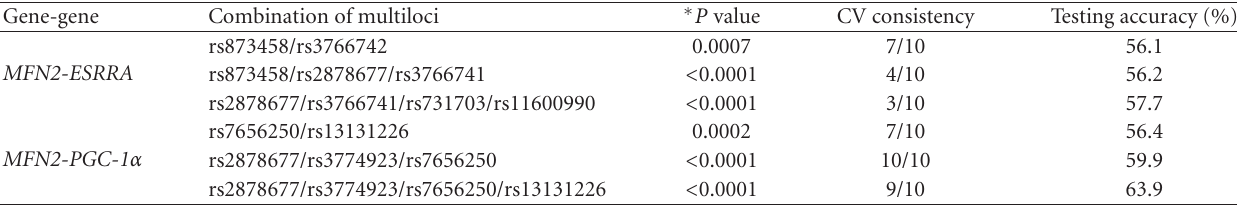
Table 5: Models of multi-loci interaction on the risk of T2D by